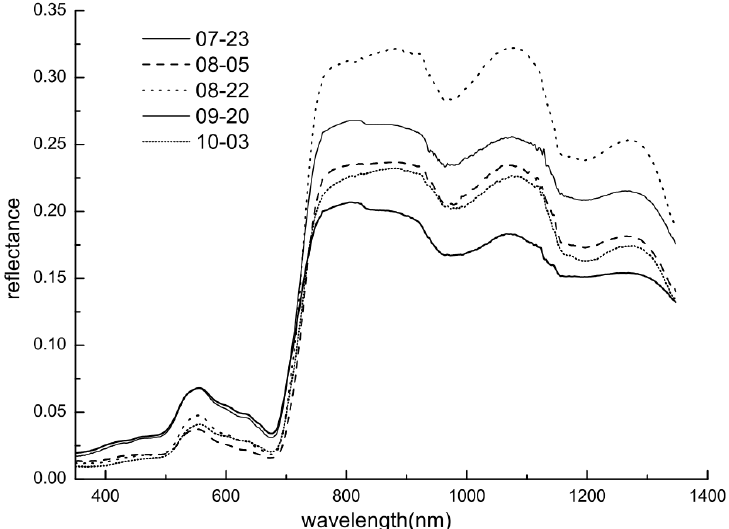
Figure 3. Average reflectances of the rice canopy at the N1 level of N fertilization at different growth stages in 2002.